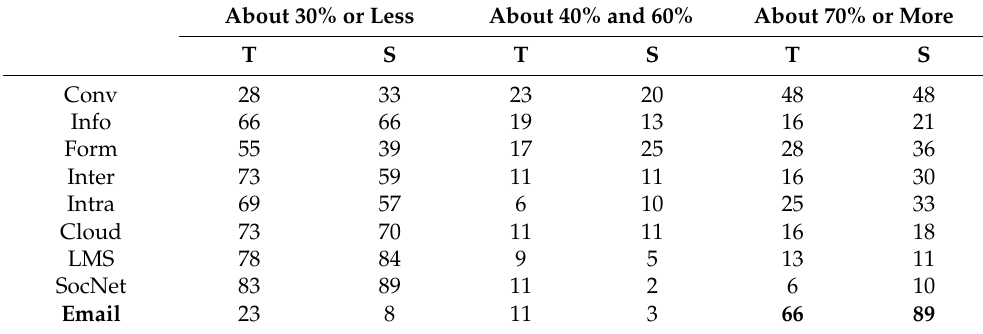
Table 7. Percentages of answers for the components in question 18 regarding field of science.